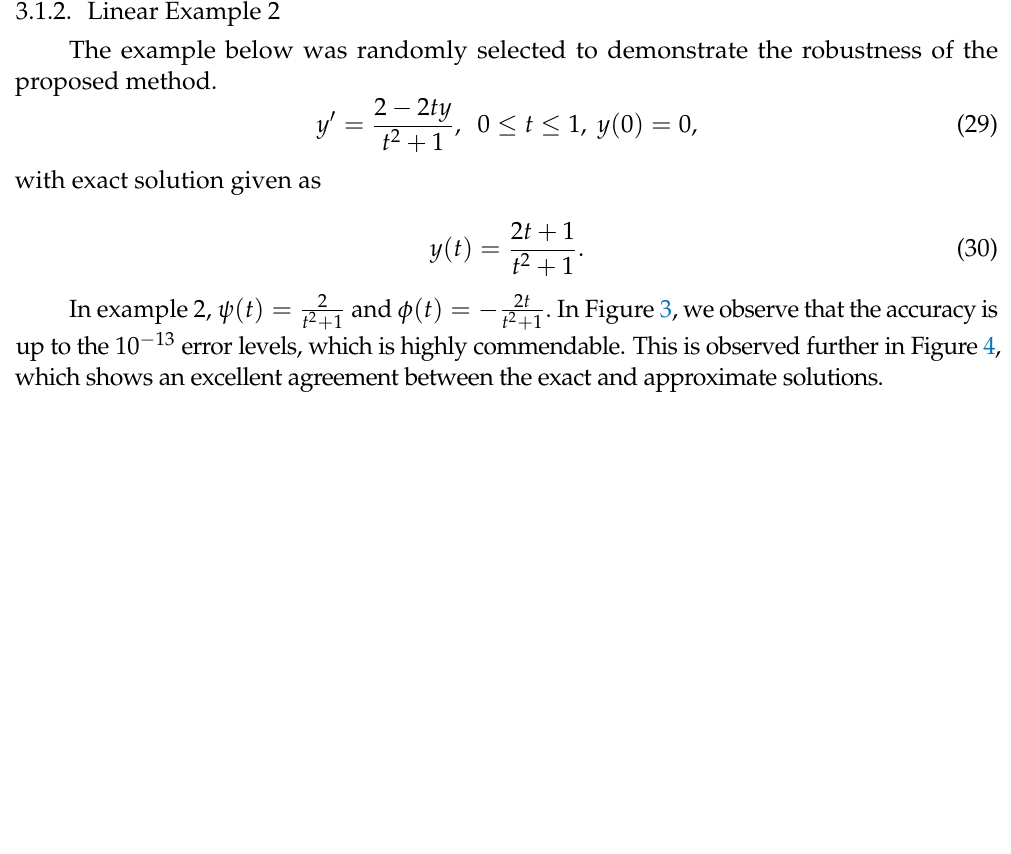
Figure 2. Graphs of the exact and approximate solutions for example